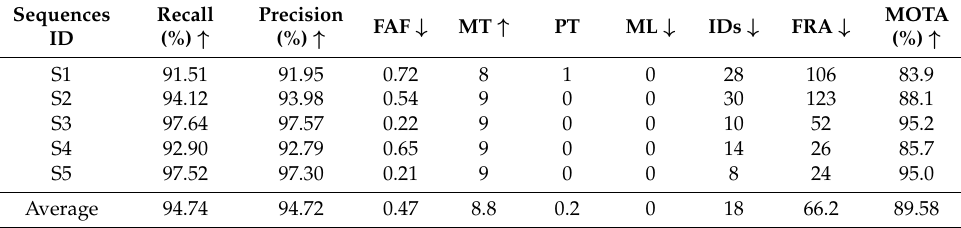
Table 3. Evaluation results of our method for individual pigs’ detections and tracking.